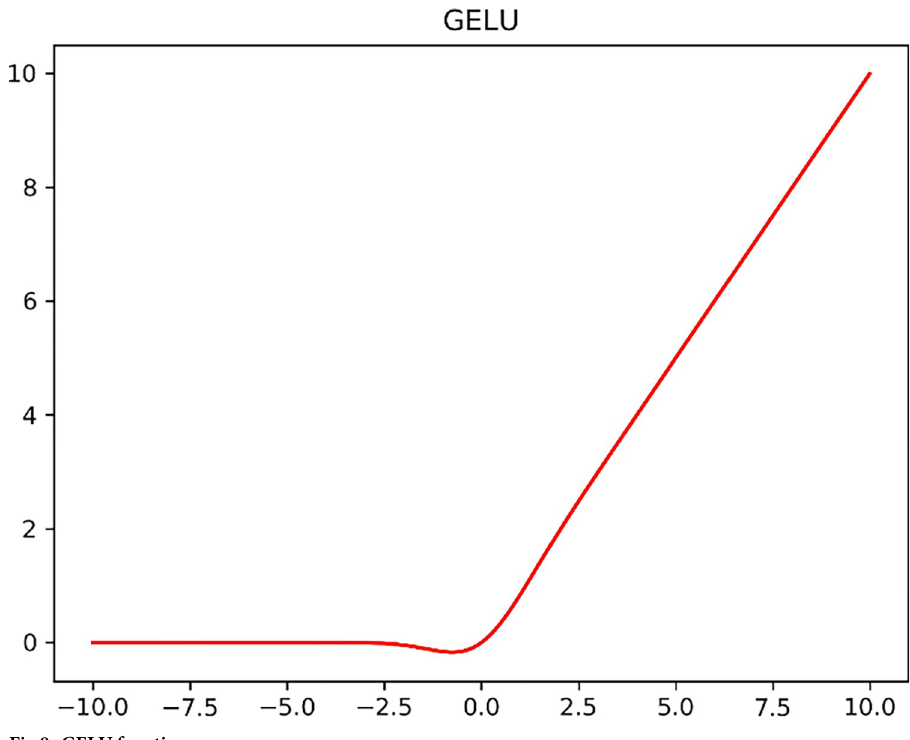
Fig 8. GELU function.